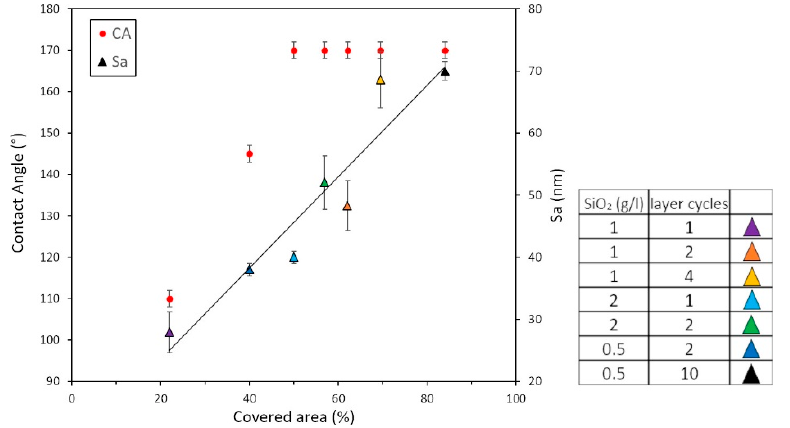
Figure 3. CA values and surface roughness (Sa) versus the percentage of covered area. (The black line is the trend line). The legend reports the operational conditions for each sample.